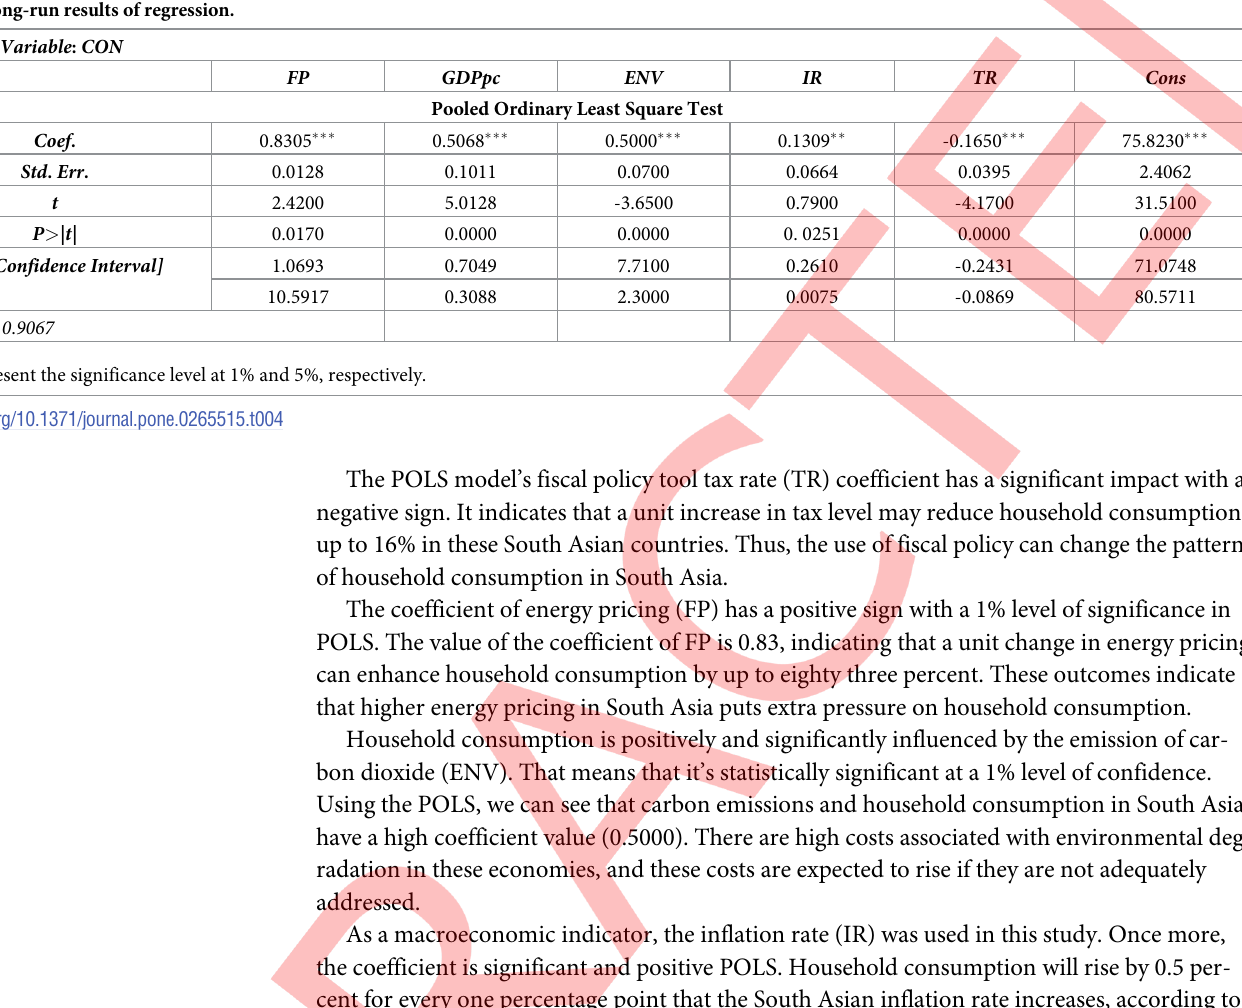
Table 4. Long-run results of